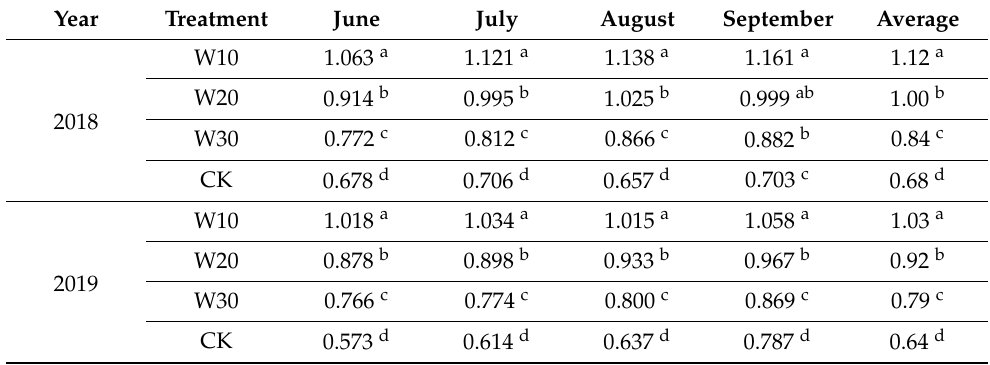
Table 4. Groundwater table in 2-year growth